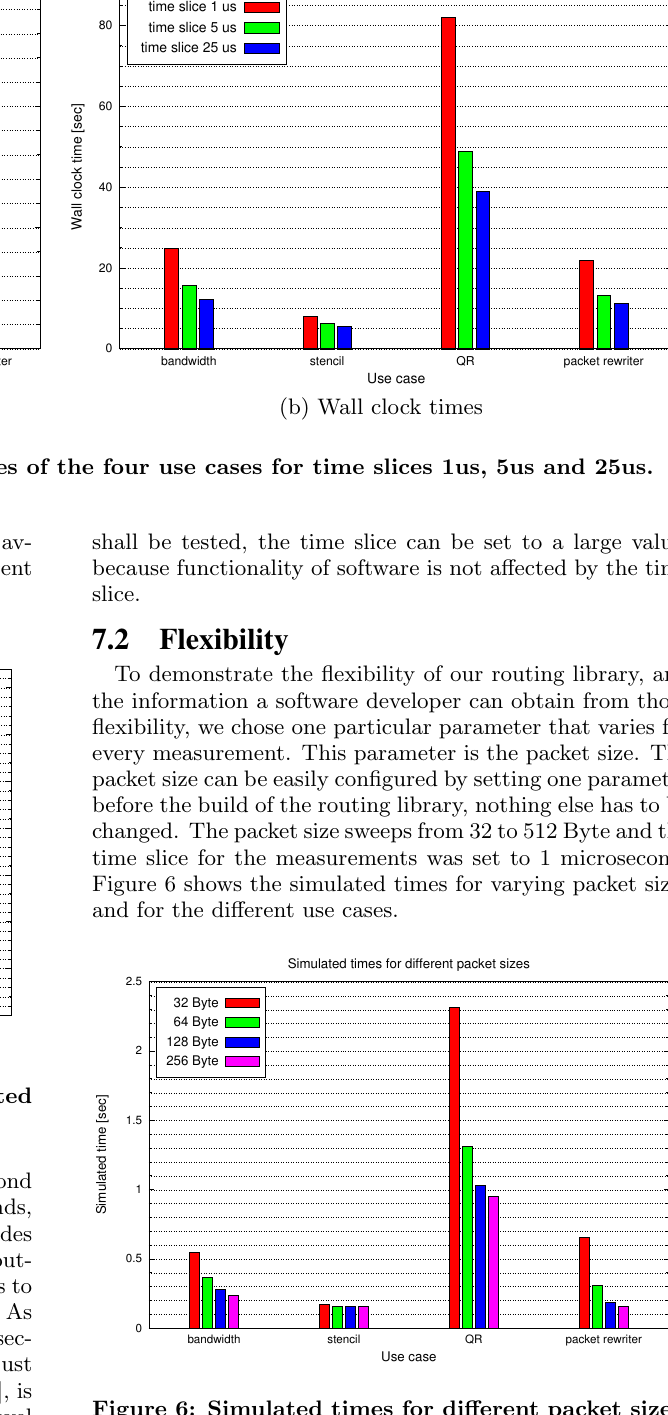
Figure 6: Simulated times for different packet